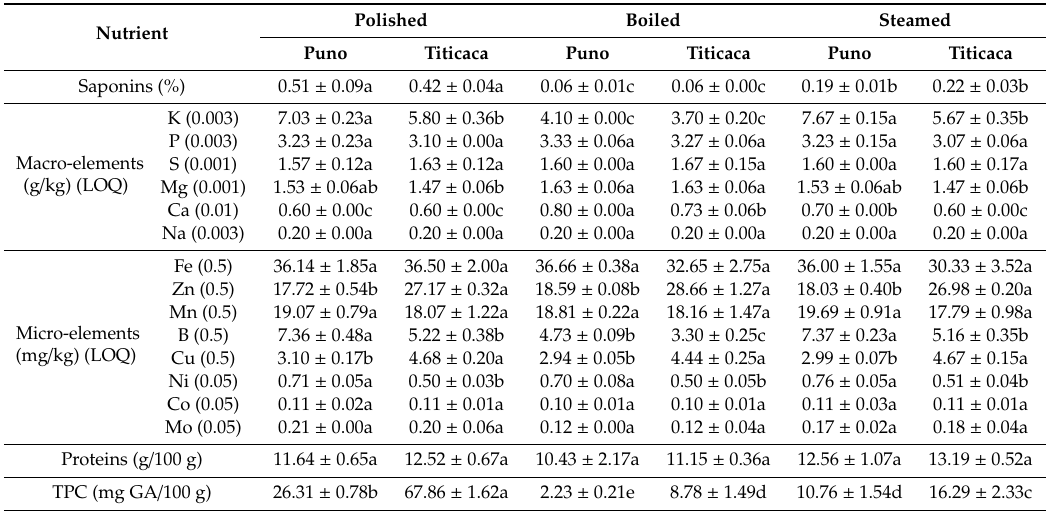
Table 3. Means and standard deviations of mineral concentrations, proteins content, TPC, and saponins content in boiled and steamed quinoa seeds. Nutrient